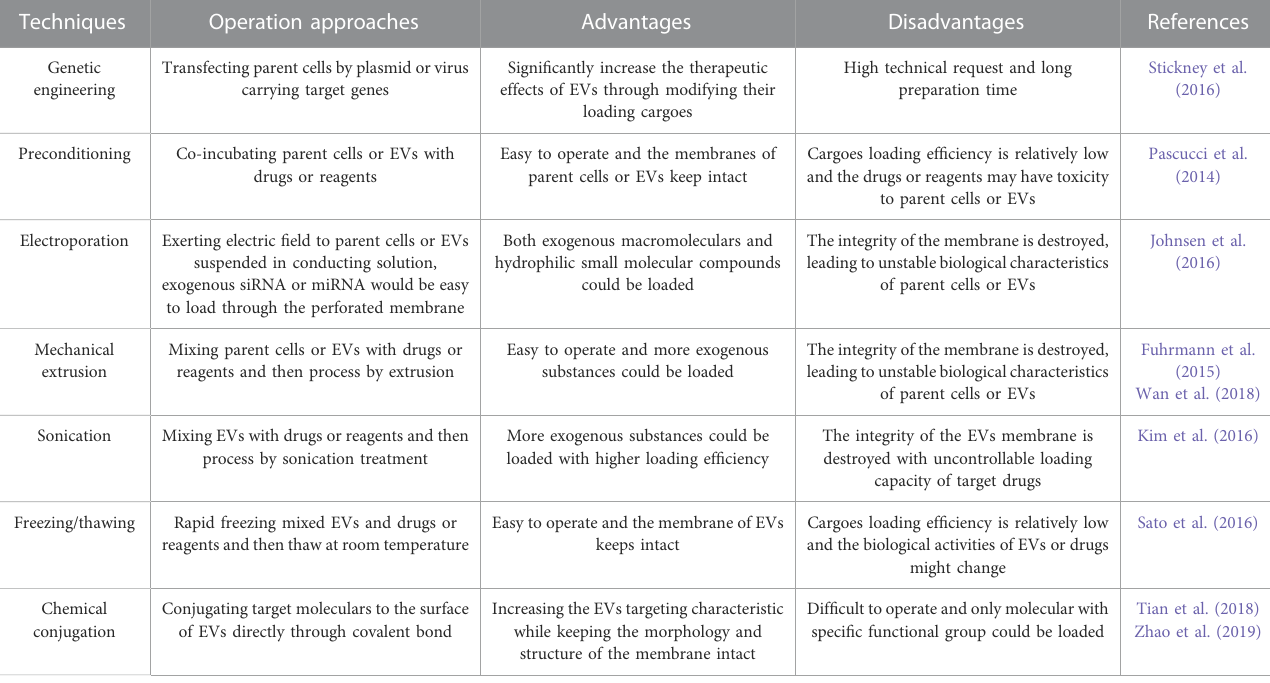
TABLE 3 Commonly applied techniques for engineering modi fi ed EVs